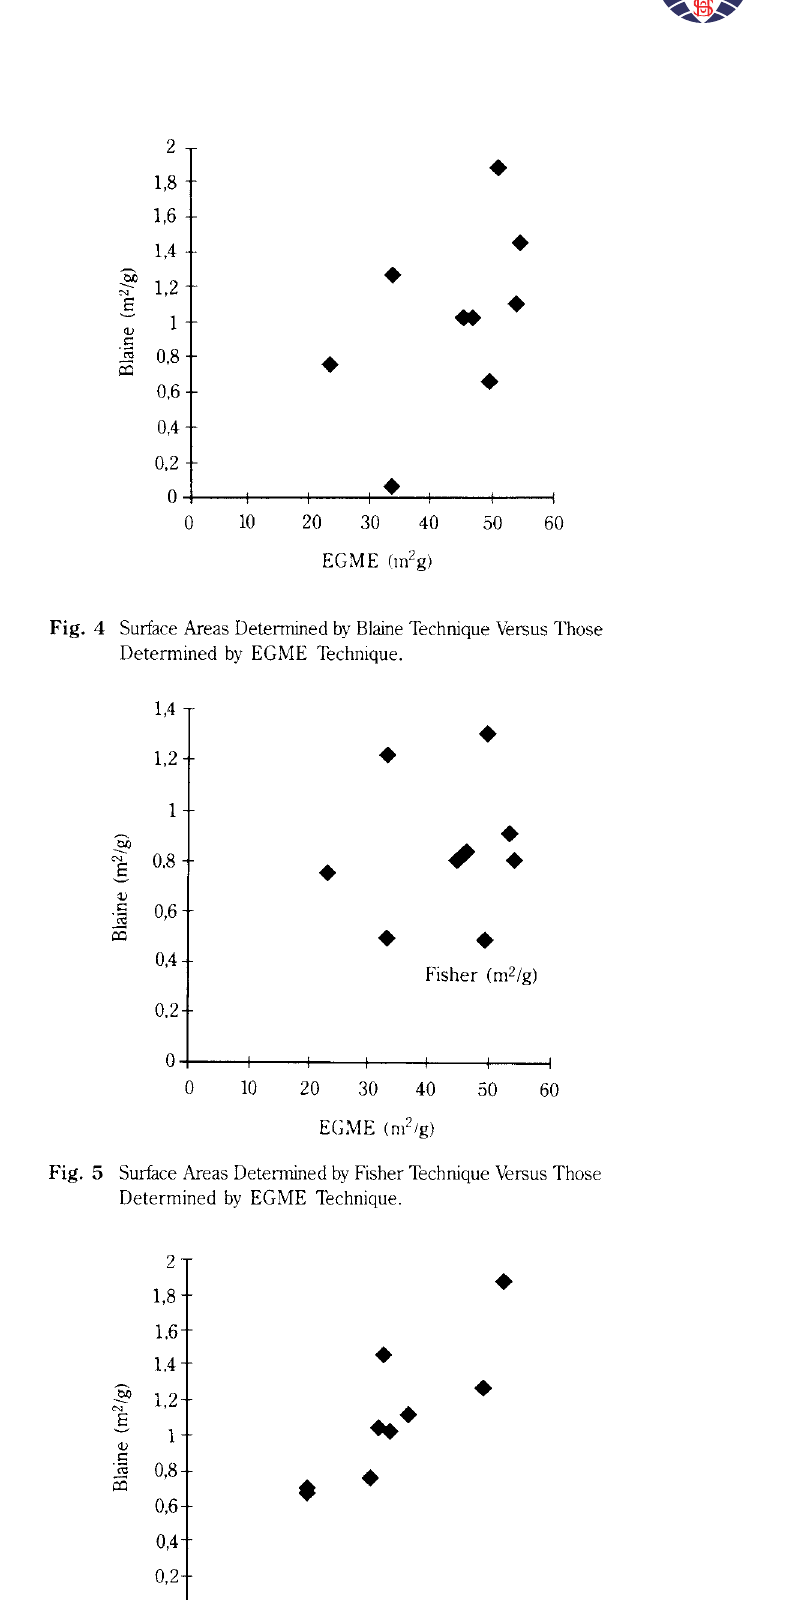
Fig. 3 Surface Areas Determined by :V1ethylene Blue and BET Techniques Versus Those Determined by EG:V!E Technique.